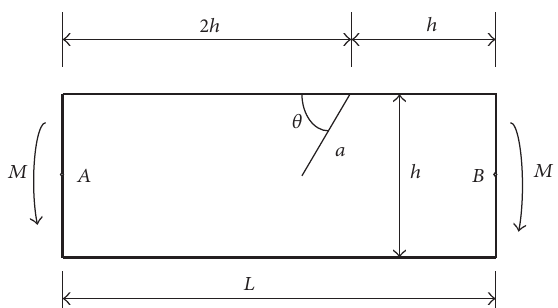
Figure 3: Geometric shape of a rectangular cracked plate under a bending